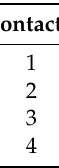
Table 1. Adhesion measurements showing the required force to break the bonding wire.